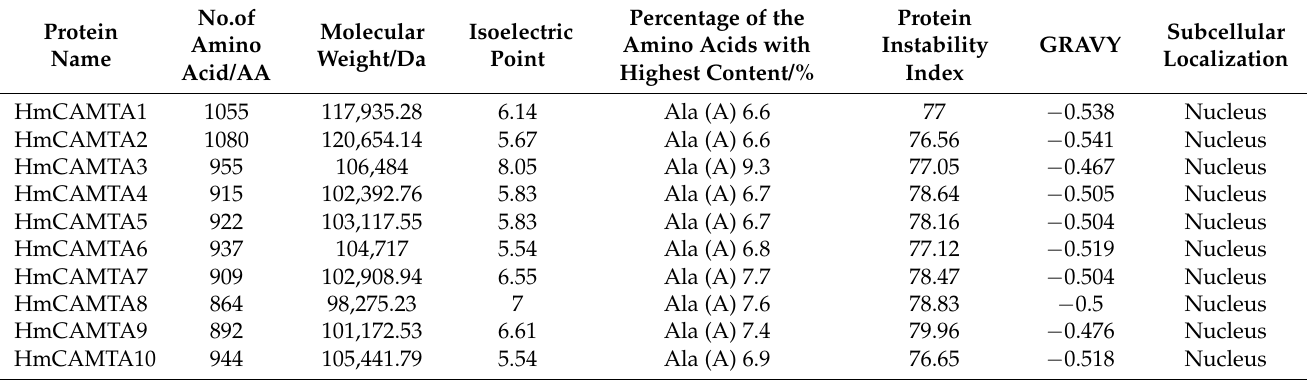
Table 1. Prediction of physicochemical properties of HmCAMTA.